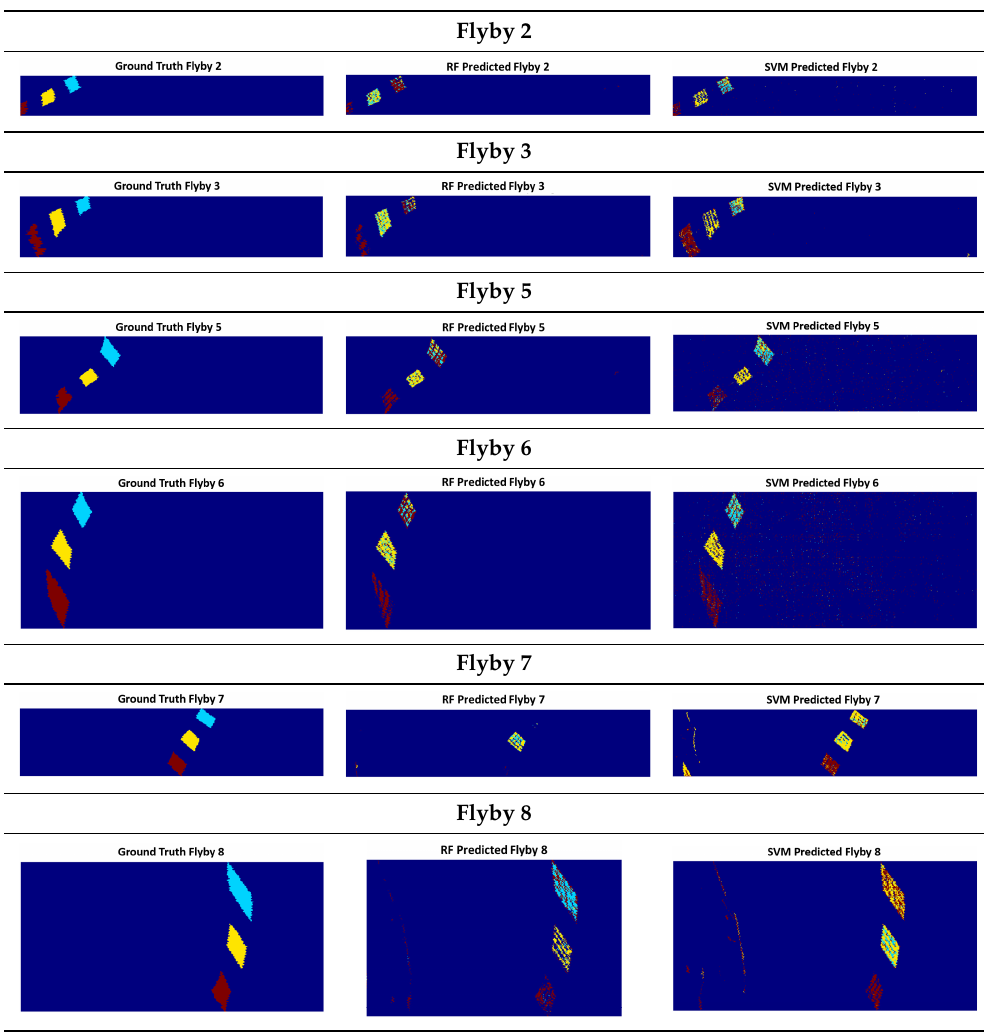
Table 7. Figures showing the results obtained for the test data (20 September 2020 flight) for random forest (RF) and support vector machine (SVM) algorithms. In the first column are illustrated the ground-truth for each flyby, the second column shows the prediction made by the random forest algo- rithm, and the last column represents the predicted values by the support vector machine